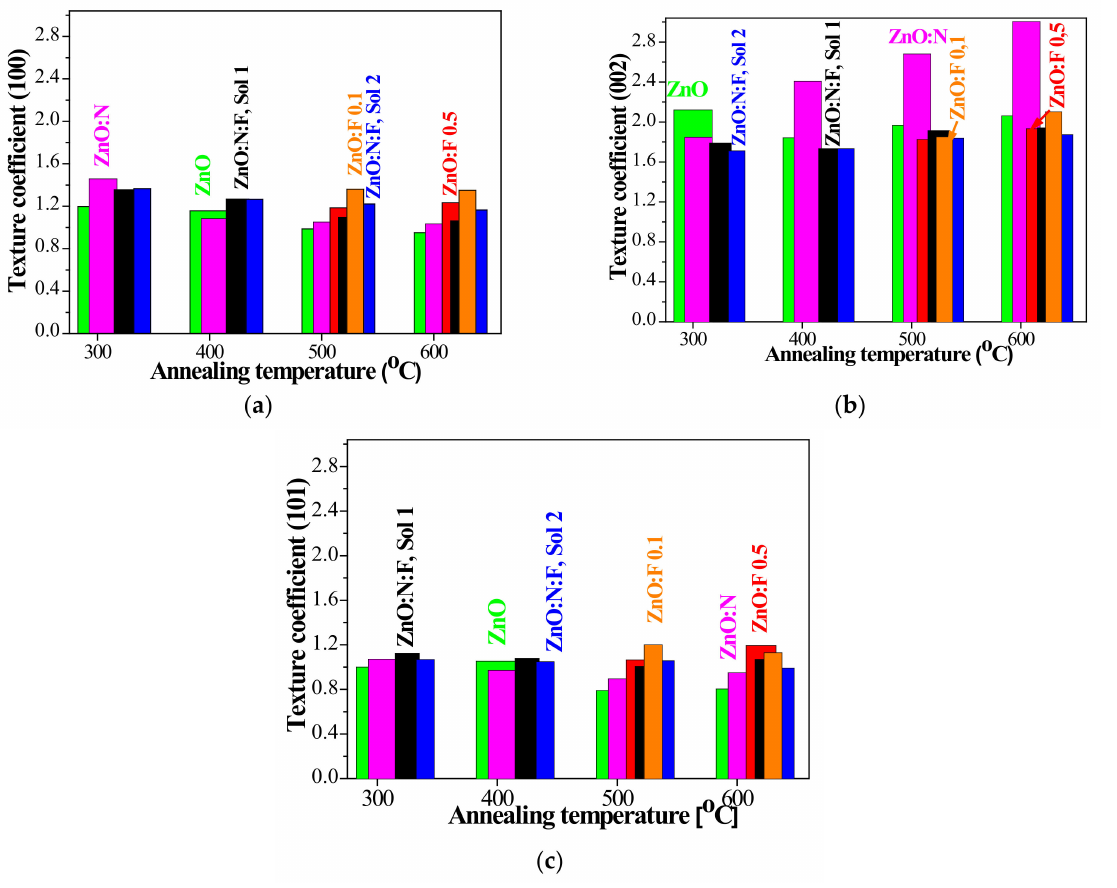
Figure 4. Texture coefficients of ( a ) (100), ( b ) (002) and ( c ) (101) peaks of ZnO based films as a function of the annealing